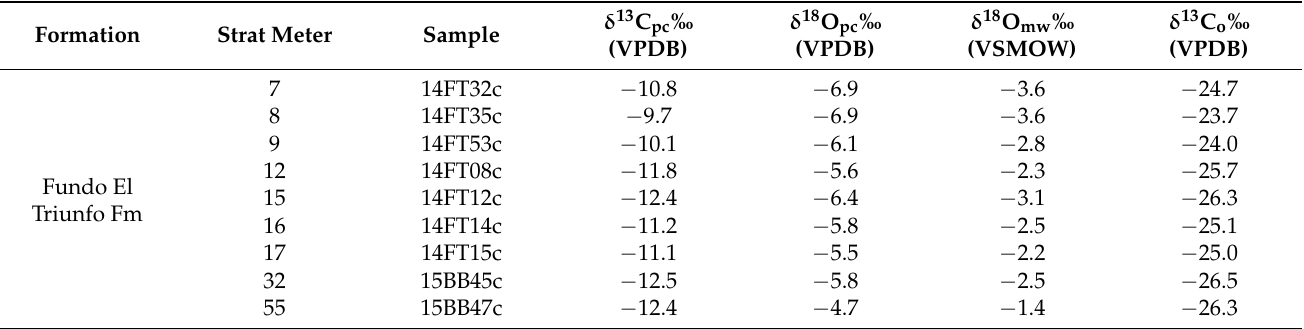
Table 4. δ 13 C and δ 18 O values for the pedogenic carbonates samples from the Fundo El Triunfo and Sambimera